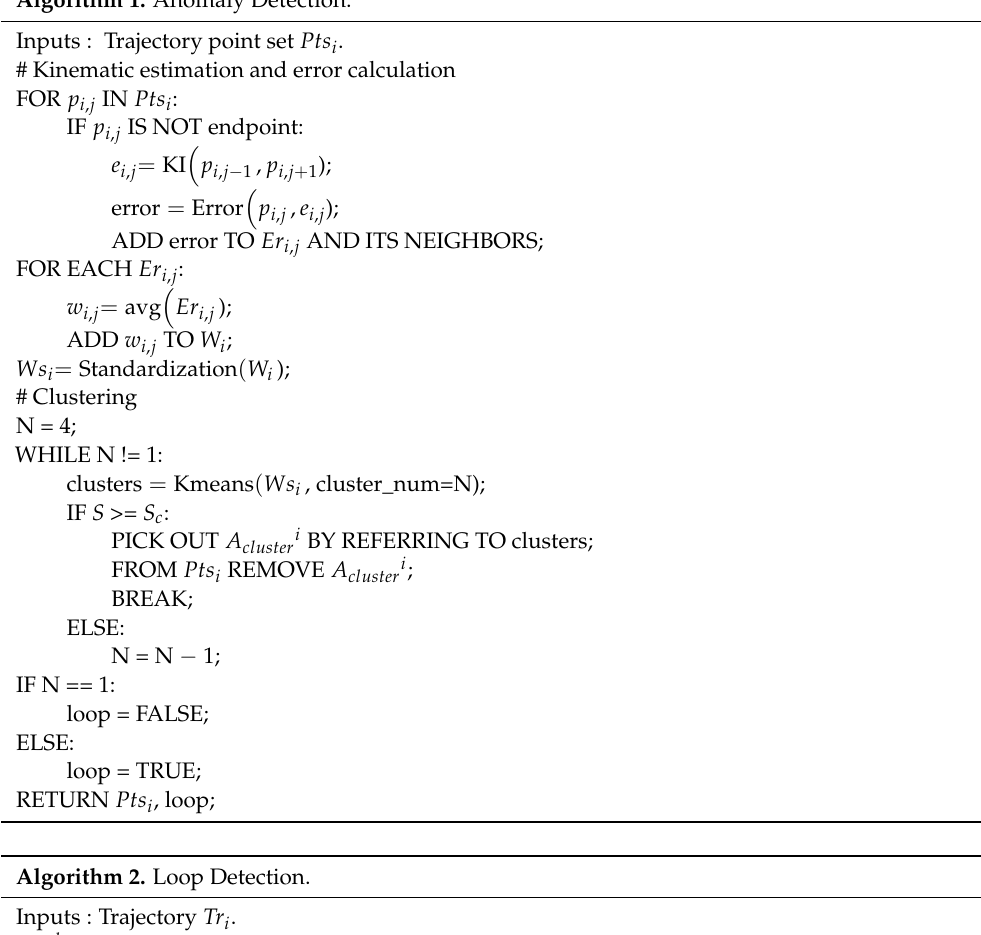
Algorithm 1. Anomaly Detection.